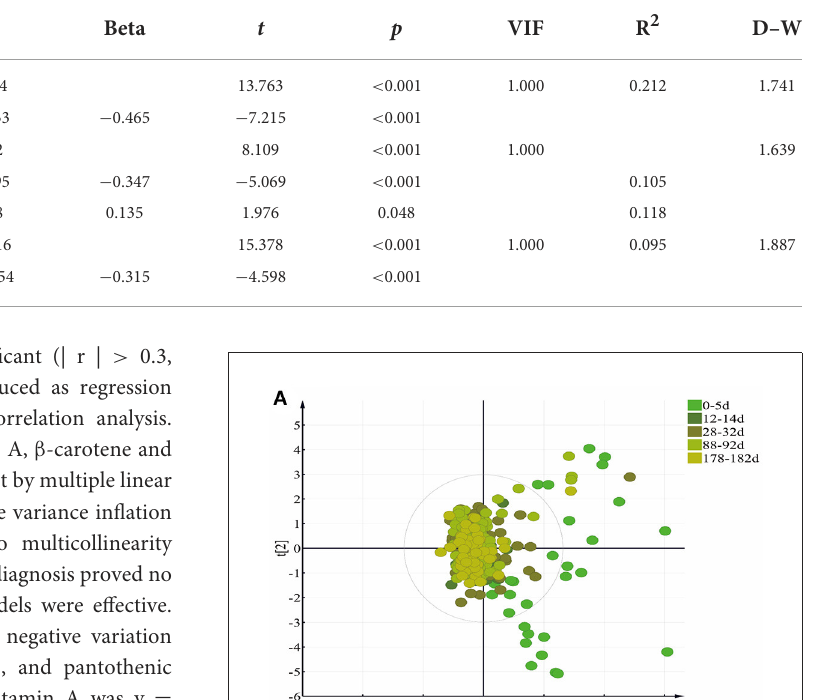
TABLE 2 Associations between mother-infant factors and HM vitamins according to multiple linear regression analyses.